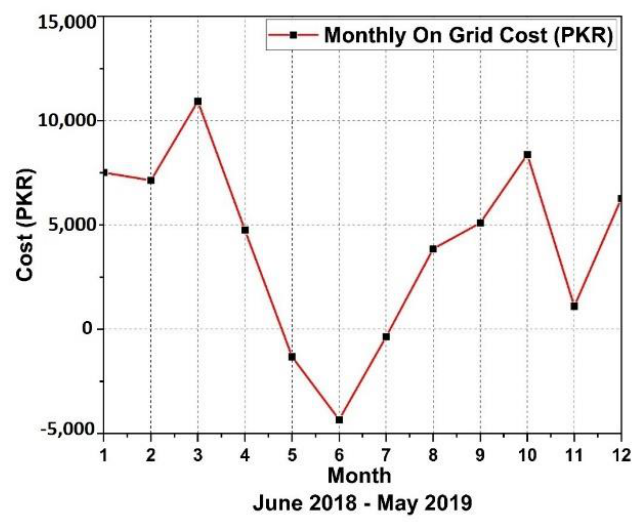
Figure 16. Monthly on − grid model costing.